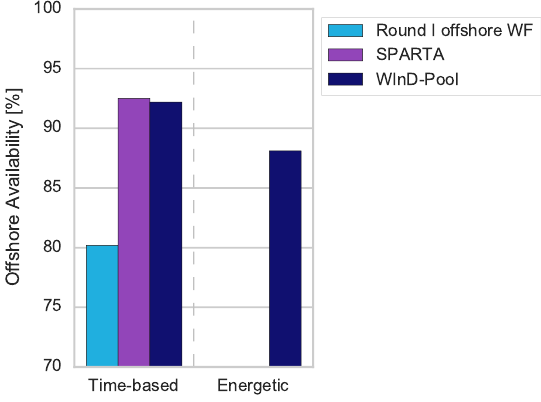
Figure 4. Availability of offshore WT as published by different